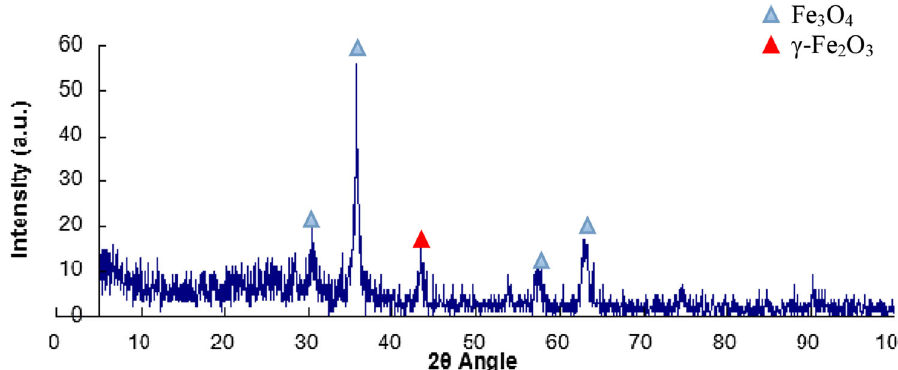
Fig. 11 FTIR spectrum of MPKSF and MPKSF–As Fig. 12 XRD diffractogram of